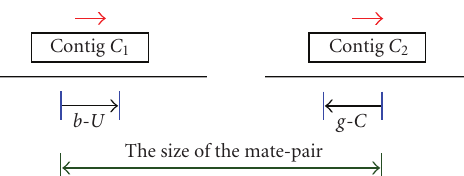
Figure 1: An example of mate-pair information. Mate-pair reads are indicated as read “ b ” and “ g ” and the relative directions to encompassing contigs are denoted as “ U (same direction)” and “ C (complementary